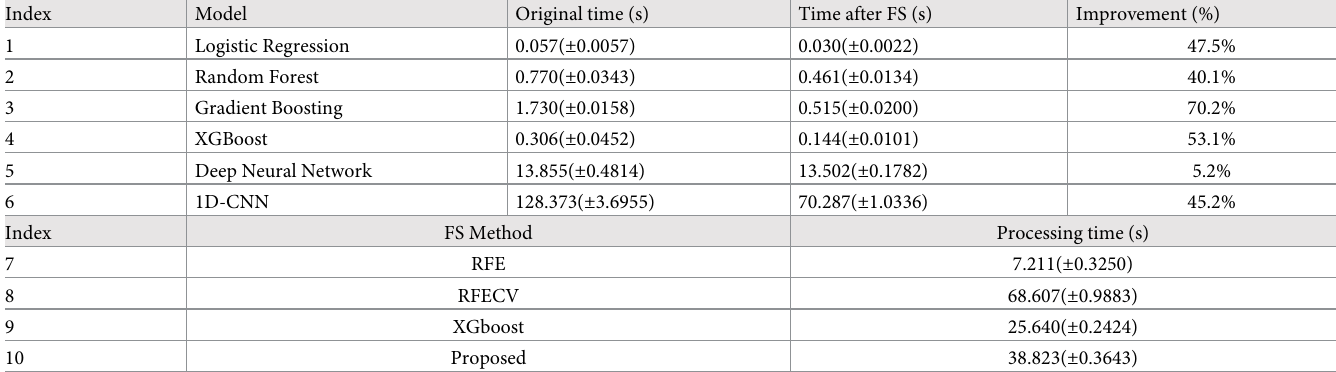
Table 10. Time performance comparison of ACS prediction models and FS method.